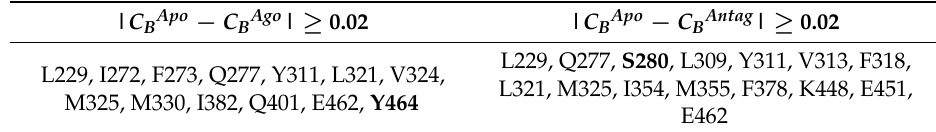
Bold residues represent the key residues identified from previous studies.